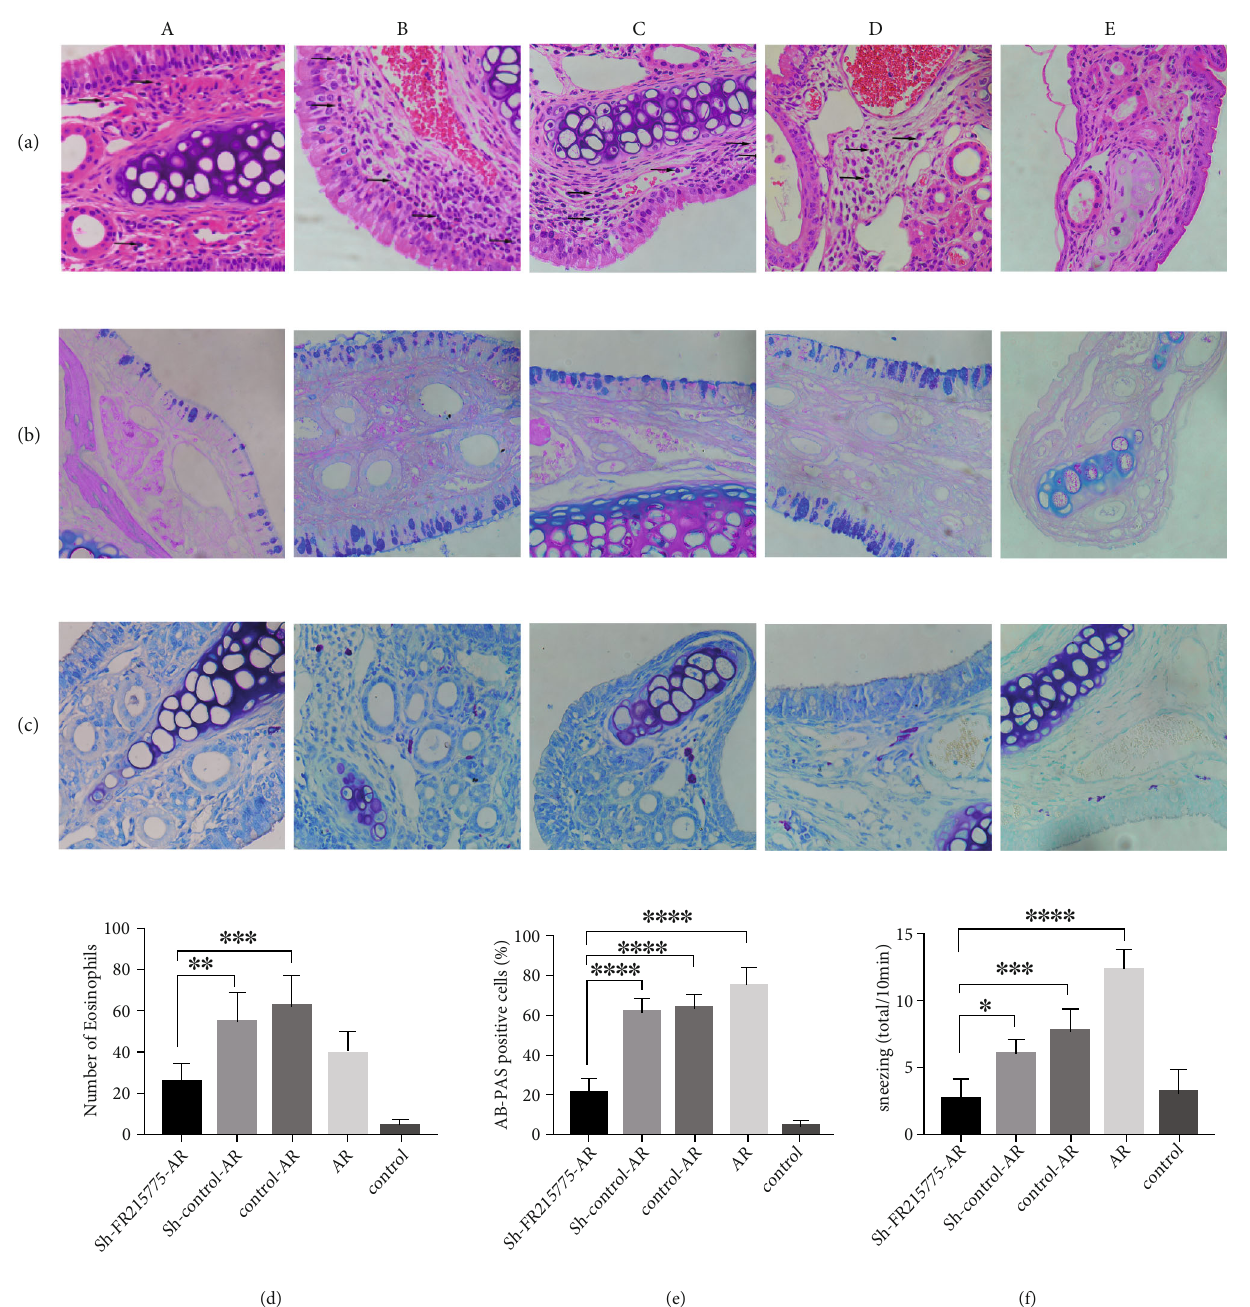
Figure 5: Histopathological staining of murine nasal mucosa. Tissue sections were stained with (a) HE staining, (b) AB-PAS staining, (c) toluidine blue staining to analyze the severity of allergic in fl ammation. Photographs of representative nasal mucosal in each group (a – c; × 400 magni fi cation; black arrows indicate stain positive cells). (d) Number of eosinophils. (e) Percent count of goblet cells. (f) Number of mast cells was signi fi cantly decreased in sh-FR215775 group ( n = 5 per group). (A) The sh-FR215775 intervention AR group. (B) The sh-control intervention AR group. (C) The control cell intervention AR group. (D) The nonintervention AR group. (E) The blank control group. Data represent the mean ± SD ( ∗ P < 0 : 05 , ∗∗ P < 0 : 01 , ∗∗∗ P < 0 : 001 , ∗∗∗∗ P < 0 : 0001